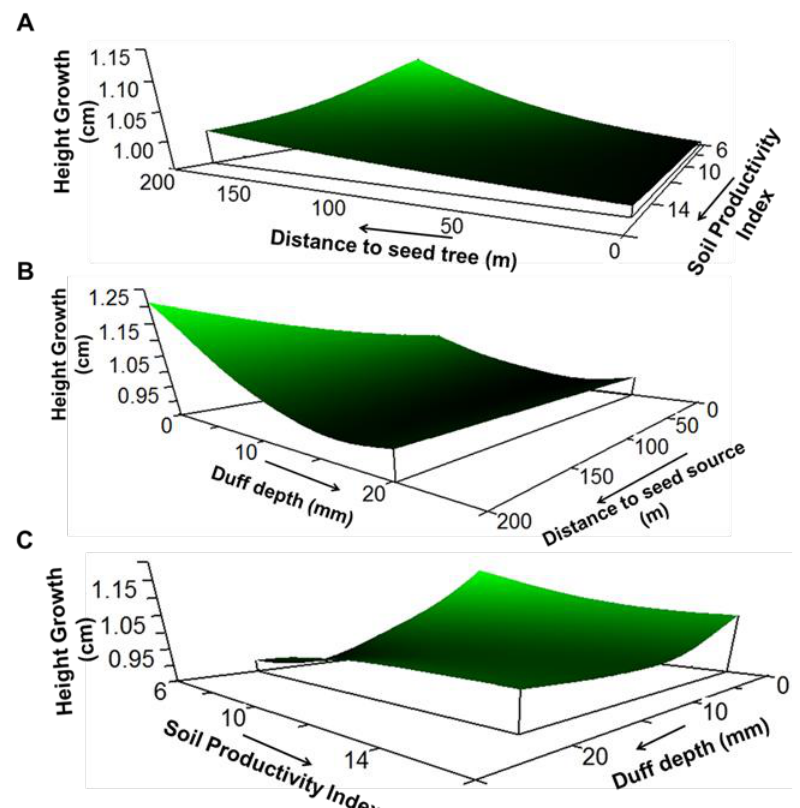
Figure 5. Average annual standardized height growth of natural ponderosa pine regeneration was impacted by distance to nearest seed source and ( A ) soil productivity index (soil PI) and ( B ) duff depth, as well as ( C ) soil PI and duff depth. Note that y -axis ranges and orientation of x -axis may vary among